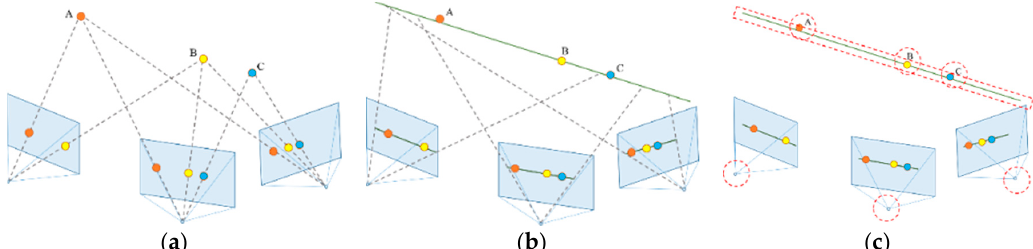
Figure 1. A toy case illustrating the proposed LAP-SLAM approach. (a) The initial coordinates of the points and poses of cameras are calculated through the geometric method, as normal point-based SLAM. (b) If two or more points are matched, such as A and B , and they are on the same detected line segments in different frames, these line segments are matched. Besides, we get the collinear relationship of A , B , and C . These line segments on different frames are parts of the projection of a 3D line, and the initial coordinate of the 3D line can be estimated from these line segments. (c) Then, we run the line-assisted bundle adjustment (BA), to optimize the poses of cameras, and coordinates of points and lines, considering the collinear relationship (the optimized parameters are framed by red dashed lines).